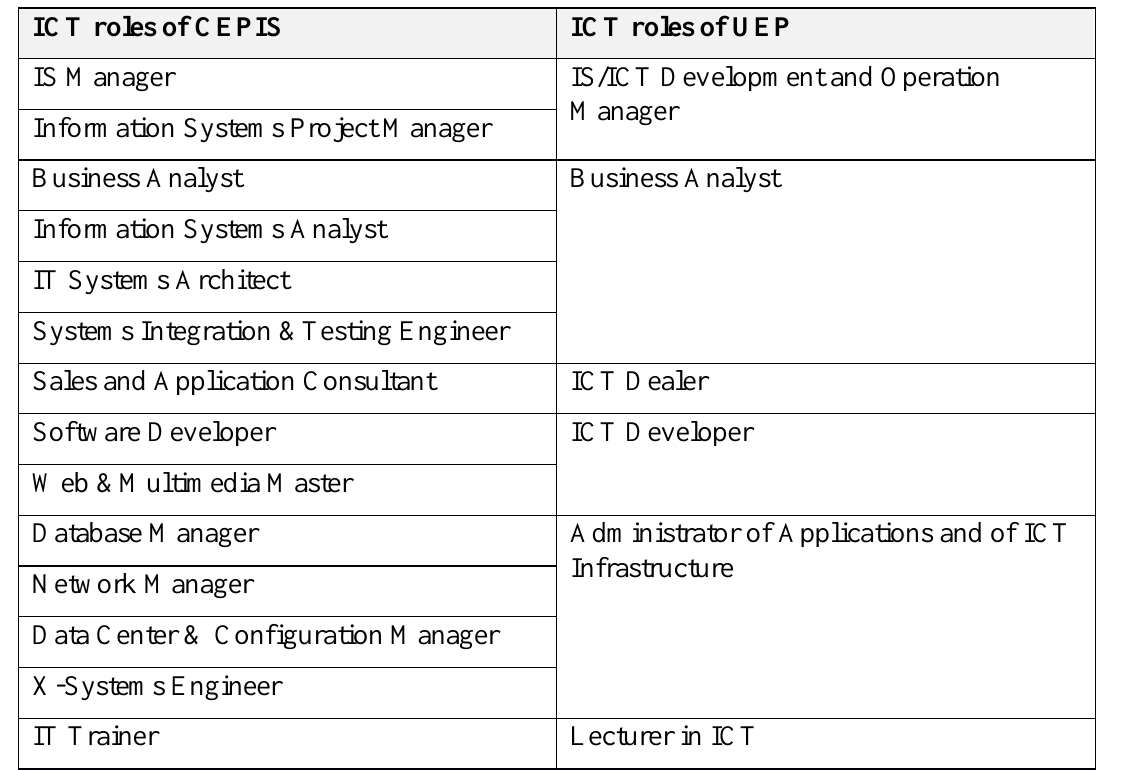
Table 2 – Role Mapping Between University of Economics in Prague and CEPISsource: authors, (CEPIS,